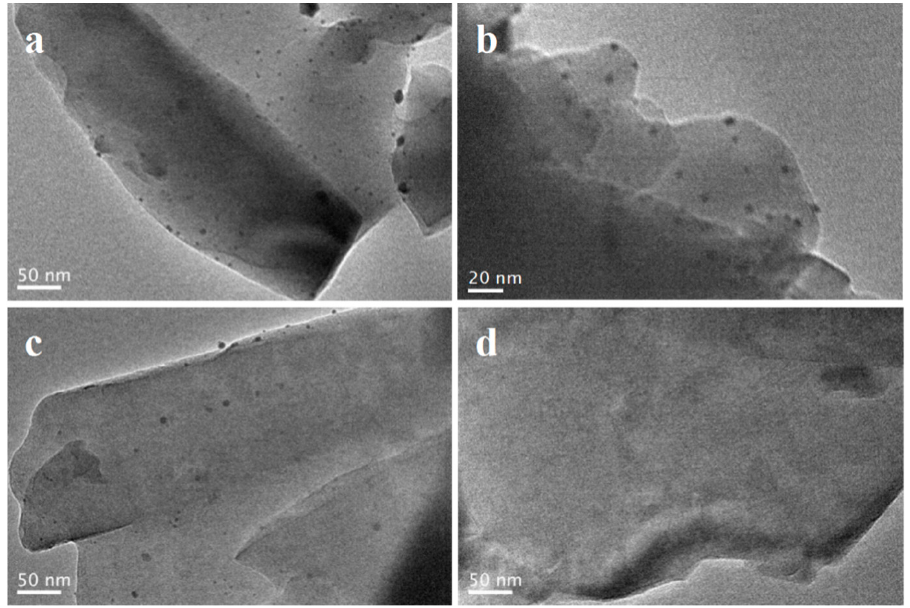
Figure 2. TEM images of the as-prepared Pt8Co1/ZSM-5-AT ( a , b ), Pt/ZSM-5-AT ( c ) and Co/ZSM-5- AT ( d ) catalysts.